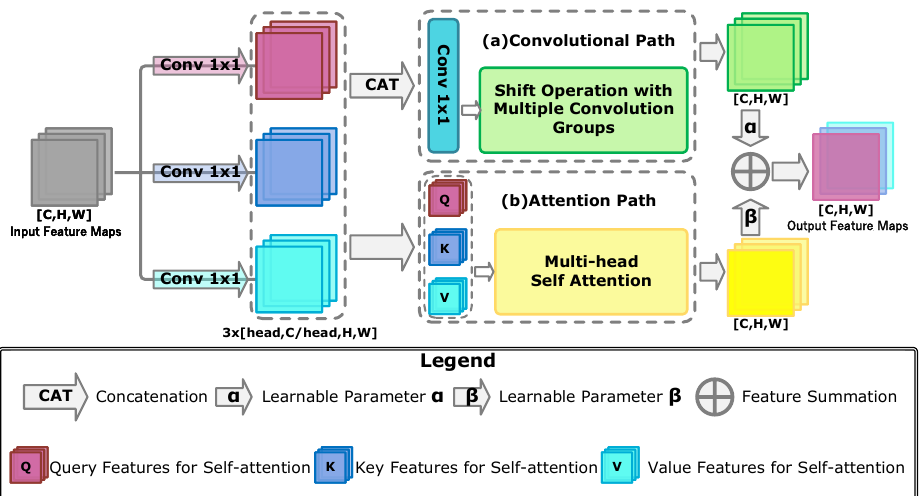
Figure 4. A brief illustration of the employed